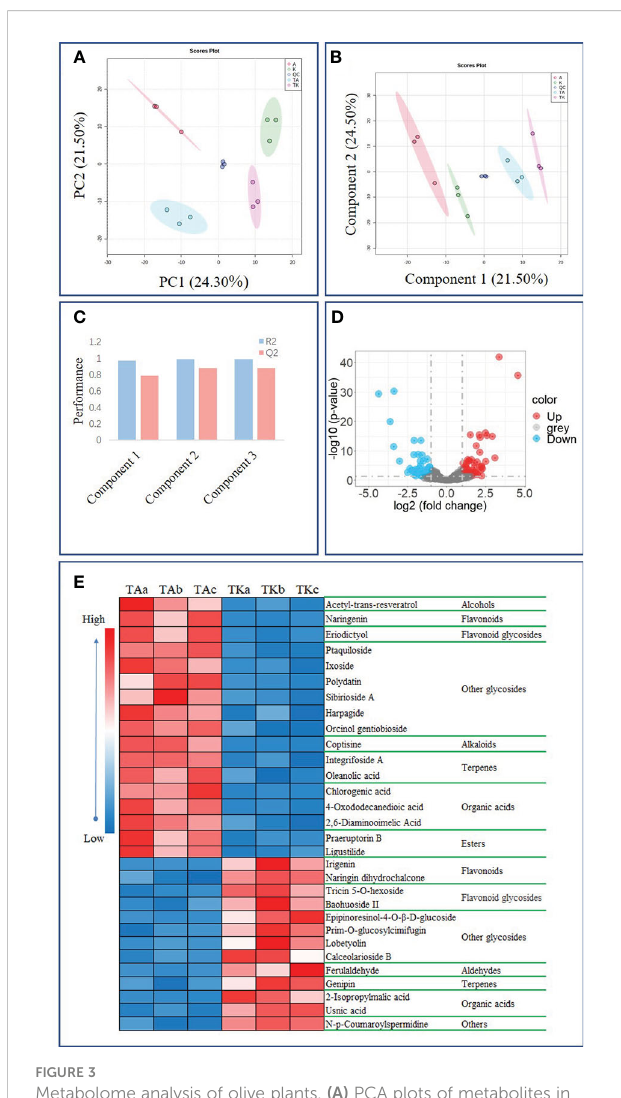
FIGURE 3 Metabolome analysis of olive plants. (A) PCA plots of metabolites in olive plants. (B) PLS-DA plots of metabolites in olive plants. (C) Tenfold cross-validation of PLS-DA. (D) Volcano plots of DAMs between TA and TK. (E) Heat map of the top 30 DAMs between TA and TK. ‘ TA ’ and ‘ TK ’ represent Arbequina and Koroneiki under cold